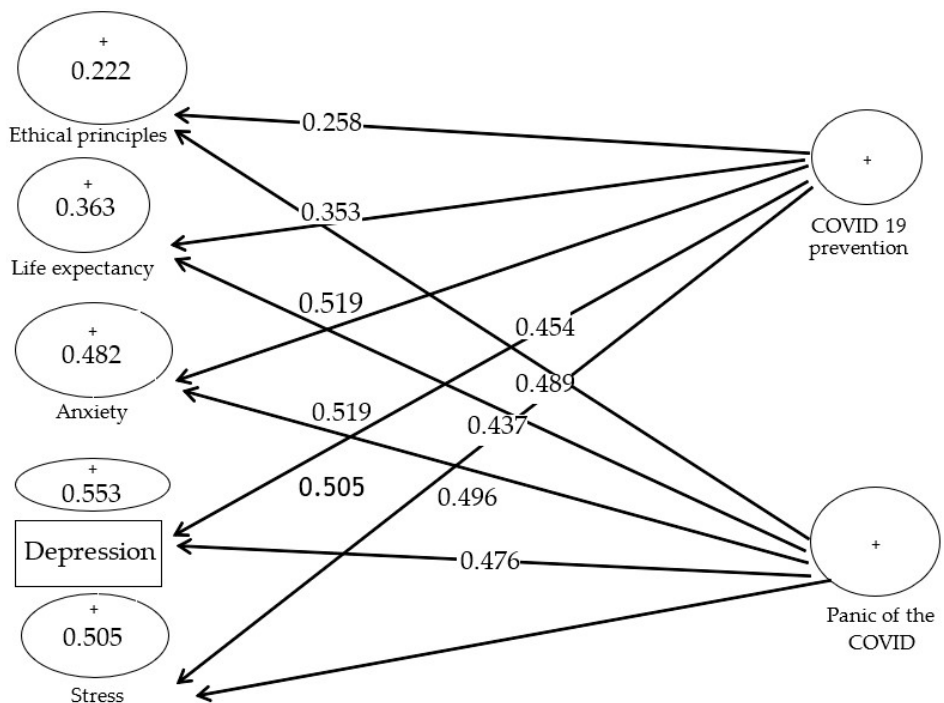
Figure 3. The t significance coefficients.